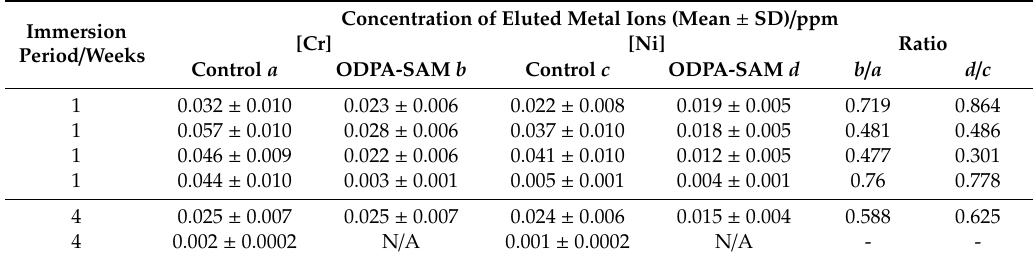
Figure 3. Concentration of eluted metal ions from the polyamine-modified dental wire. 1 M lactic acid for one week and 0.1 M lactic acid for four weeks; left: Cr ions, right: Ni ions. ( p < 0.05). Table 2. Concentration of eluted metal ions from the modified wire immersed to several